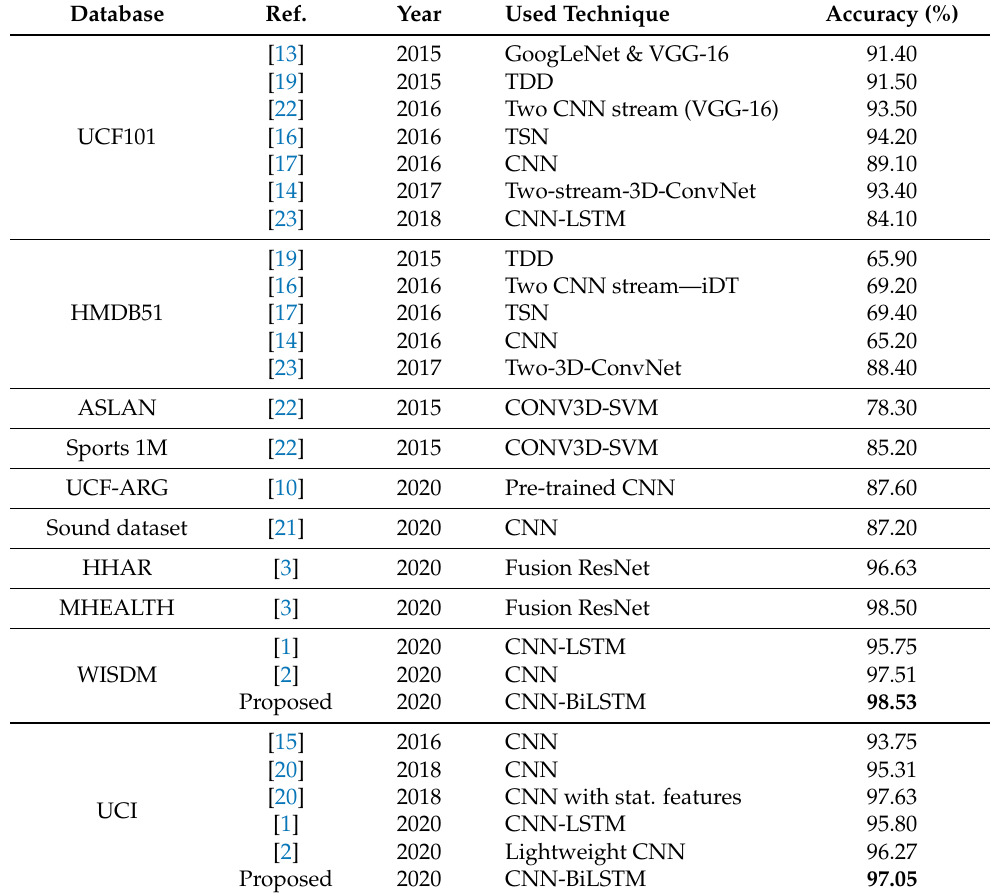
Table 8. Comparison with other studies conducted on different human activity recognition (HAR)